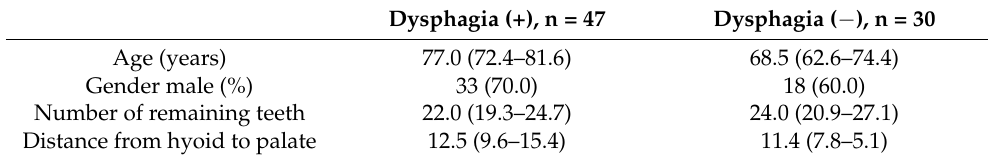
Table 1. Clinical characteristics of patient groups divided by presence of dysphagia by VF exam.